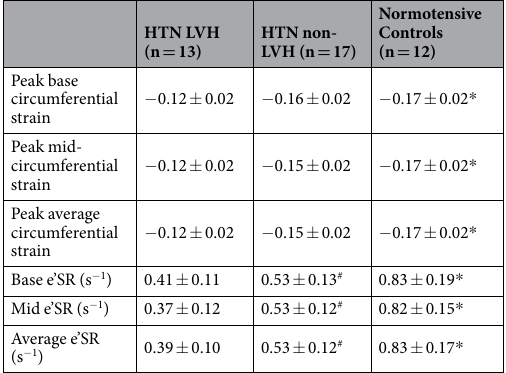
Table 3. Strain and Strain Rate among the HTN LVH, HTN non-LVH and Normotensive Controls. Values are Mean ± SD. * p < 0.05 vs. HTN LVH, # p < 0.05 vs. HTN non-LVH. e’SR = early diastolic circumferential strain rate; LVH = Left ventricular hypertrophy.